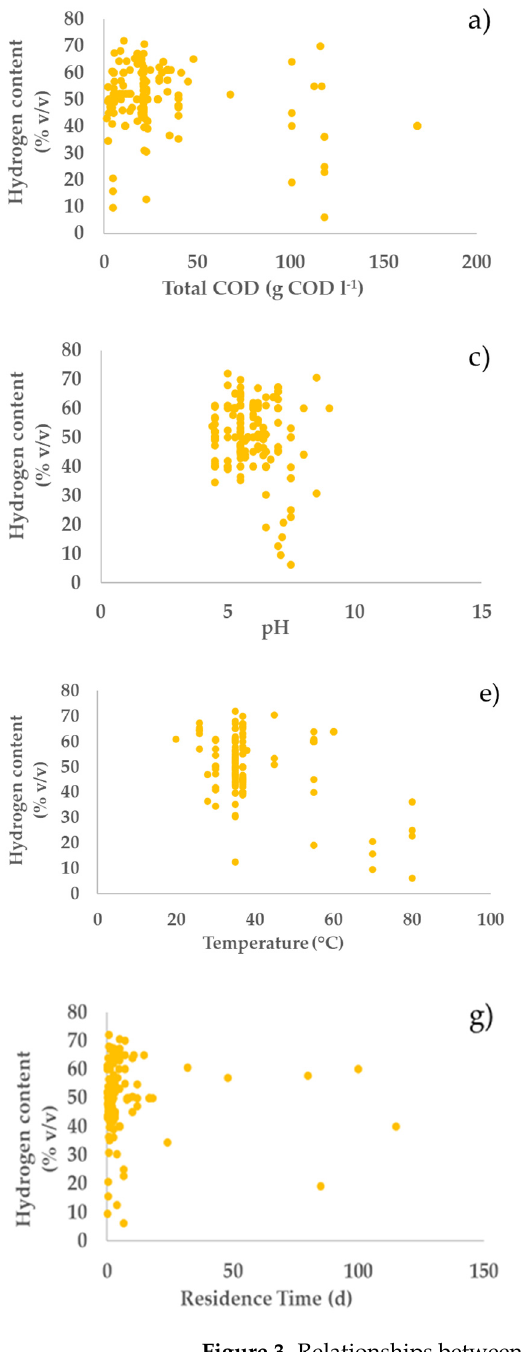
Table 3. Mean, with standard error (in bracket), and 90th percentile values of process performance parameters.